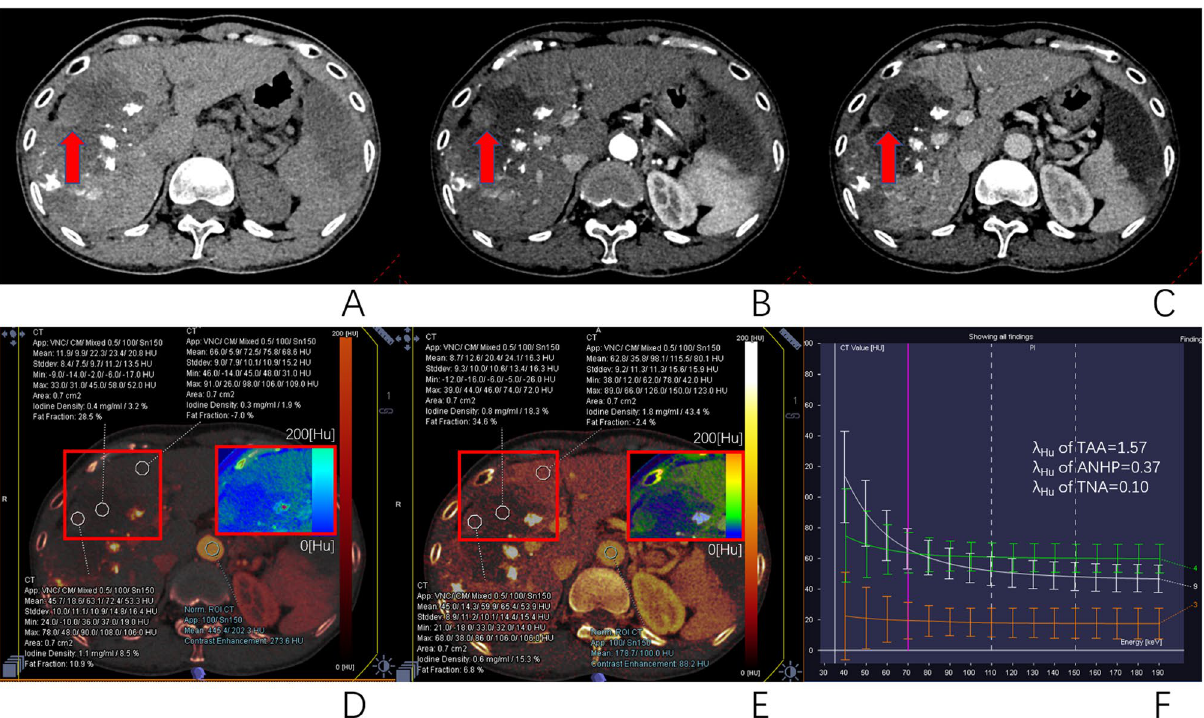
Figure 2. This is a patient who had a DECT examination 7 weeks after the conventional-TACE, showed that lipiodol deposited around the tumor, and TAA and TNA in the tumor after treatment. A large lesion with scattered lipiodol deposition is seen within the right lobe of the liver. The center non-enhancing area was TNA. Peripheral soft tissue nodularity is noted on axial non-enhanced CT (red arrow, A ), with slight enhancement on arterial phase ( B ), and portal venous phase ( C ), which was considered by radiologists to be TAA. ROIs of TAA, ANHP, and TNA placed on arterial phase and portal phase iodine map ( D and E ) showed the IC and NIC of TAA to be 1.1 mg/ml and 8.5% at arterial phase, and 0.6 mg/ml and 15.3% at portal venous phase, respectively. The IC and NIC of ANHP was 0.3 mg/ml and 1.9% at arterial phase, and 1.8 mg/ml and 43.4% at portal venous phase, respectively. The IC and NIC of TNA was 0.4 mg/ml and 3.2% at arterial phase, and 0.8 mg/ml and 18.3% at portal venous phase, respectively. The λHu of TAA, ANHP and TNA were 1.57,0.37 and 0.10, respectively ( F Differences in dual‑energy CT parameters between different tissues. The differences in parameters between different tissues are shown in Table 4. The λ Hu , normalized iodine concentration at arte- rial phase (NICAP) and normalized iodine concentration at portal venous phase (NICPP) of the TAA were 3.32 ± 1.24, 16.51 ± 6.75% and 46.68 ± 15.10%, respectively, which were significantly higher than those in the ANHP(0.71 ± 0.39, 2.66 ± 2.05% and 39.48 ± 10.65%, respectively, P < 0.05) and TNA (0.29 ± 0.27, 2.28 ± 1.47%, and 9.30 ± 7.46%, respectively, P < 0.05); The iodine concentration difference(ICD) of the TAA was 0.56 ± 0.46 mg/ mL, which was lower than that of ANHP (1.49 ± 0.54 mg/mL). The AIF of the TAA was 0.93 ± 0.31, which was significantly higher than that of the ANHP (0.18 ± 0.14, P < 0.05) but not significantly different from the TNA (0.99 ± 0.86, P = 0.251). Figures 2, 3 and 4 provide representative images of the DECT parametric maps.